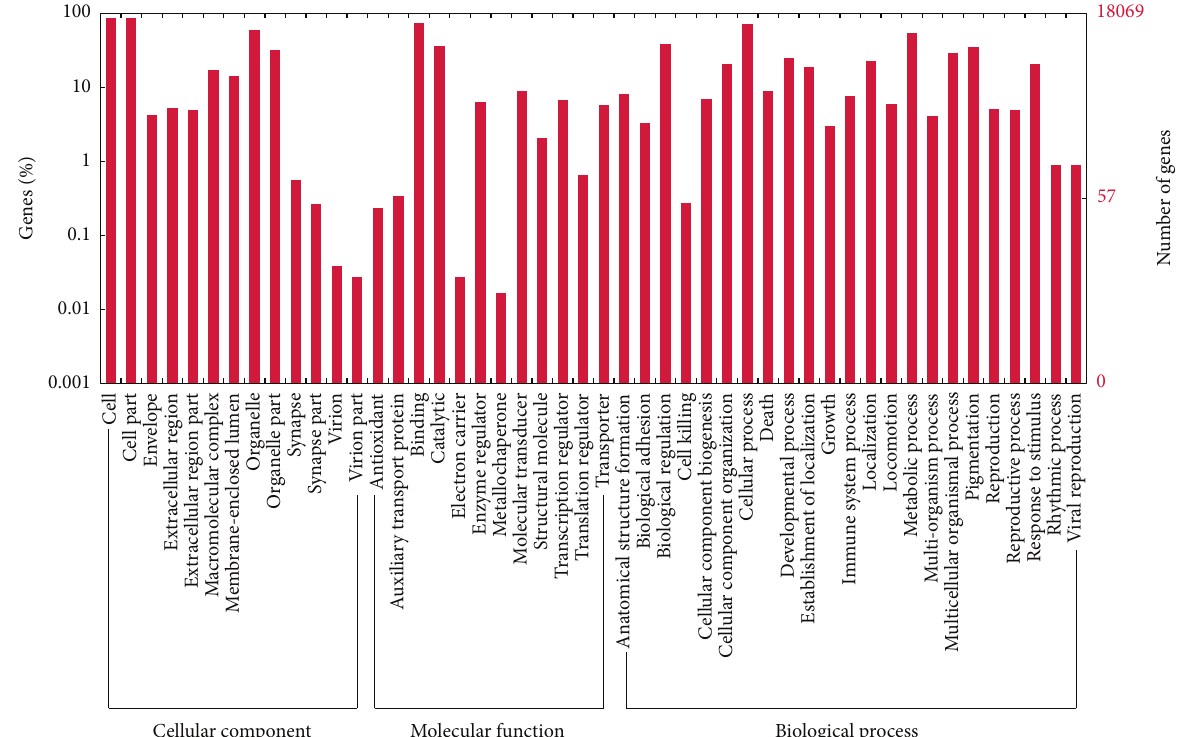
Figure 3: Gene Ontology classification of the transcriptome sequences. 18,069 transcriptome sequences can be annotated by the GO database. The classification results are displayed in the three main ontologies: cellular component, molecular function, and biological